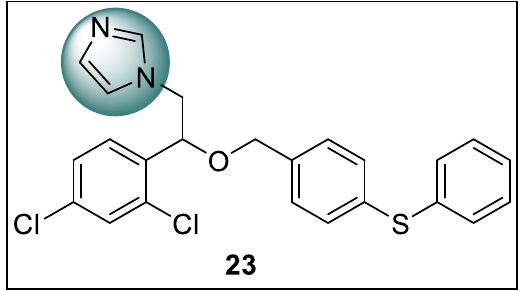
Figure 26. Structure of fenticonazole ( 23 ) .